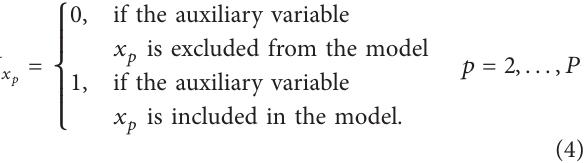
𝑂 denotes the model order, which indicates how many previous time points we use to predict the present time. It takes values ranging from 1 to ( 𝑇 − 1 ). Generally, lower and upper limits of the model order are optional. However, it is common in the literature that the model order takes values between 1 and 5. In the new method, we consider that the upper limit of the model order is ( 𝑇/3 ). That is, 𝑇 . 1 ≤ 𝑂 ≤ 3 ∈ [0, 1] ; 𝑝 = 2, . . . , 𝑃 : the indicator variables, each one 𝐼 𝑥 𝑝 takes the value 0 or 1 to indicate the absence or presence of the auxiliary variable in the model; that